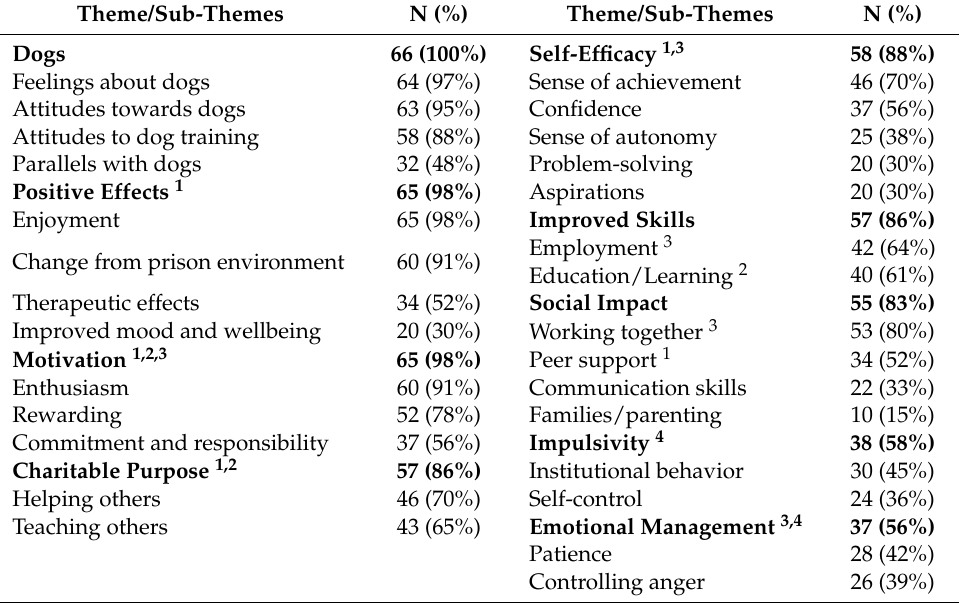
Table 1. Frequency of themes (in bold) and sub-themes in initial post-course interviews (N =